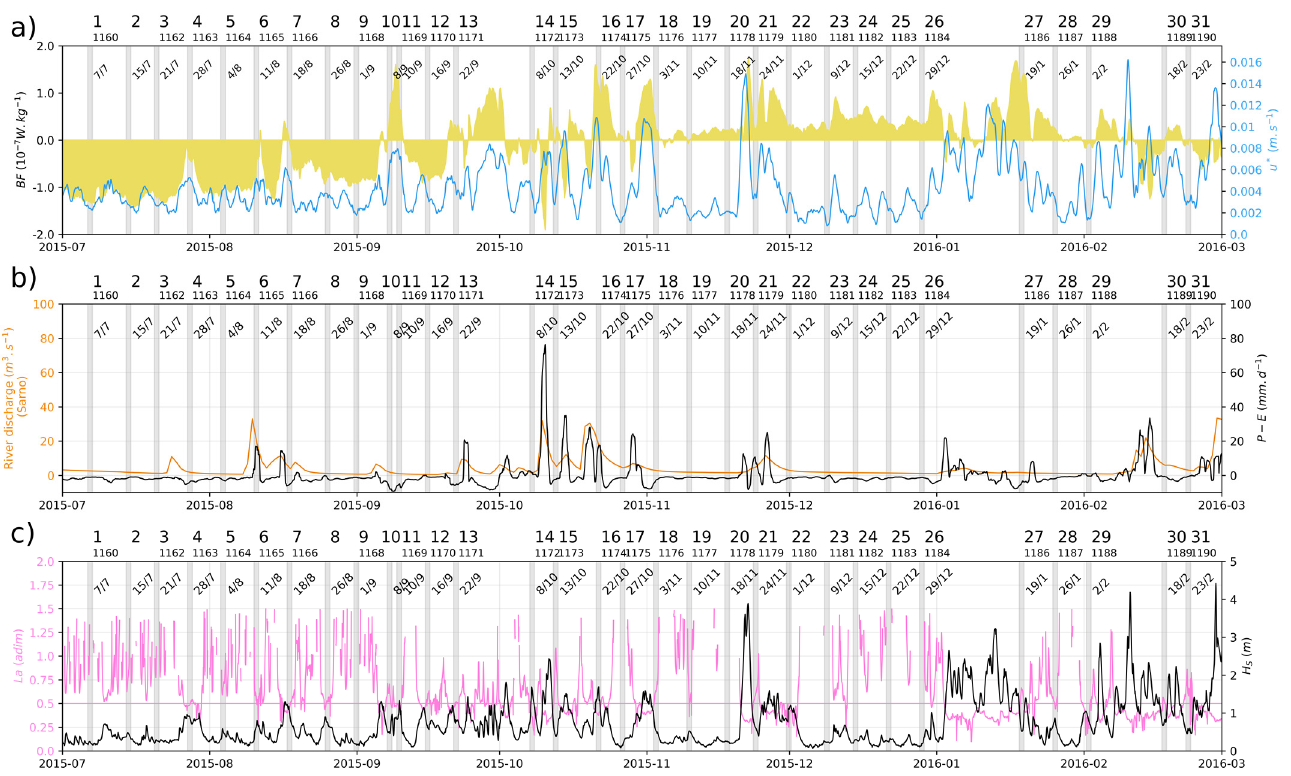
Figure 3. ( a ) Time series of the wind friction velocity (blue), buoyancy fluxes (plain yellow); ( b ) net precipitation rates (black) and river discharge (orange). River discharge is considered at the Sarno river’s mouth (see Figure 1). ( c ) Time series of the significant wave height (black) and Langmuir number (pink). All plots: the time range of the 24 h preceding each cast is indicated with the gray backgrounds; cast’s number (1–31) with the MC number (1160–1190, see Table 1) are indicated on top; cast’s date is indicated